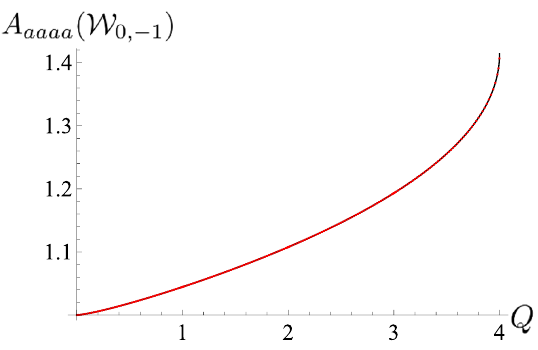
Figure 7 . The amplitude A aaaa ( W 0 , − 1 ) . Red dots are the numerical bootstrap result and the black curve is the analytic expression (3.19a). They agree perfectly (the black curve being only visible behind the red points close to Q = 4